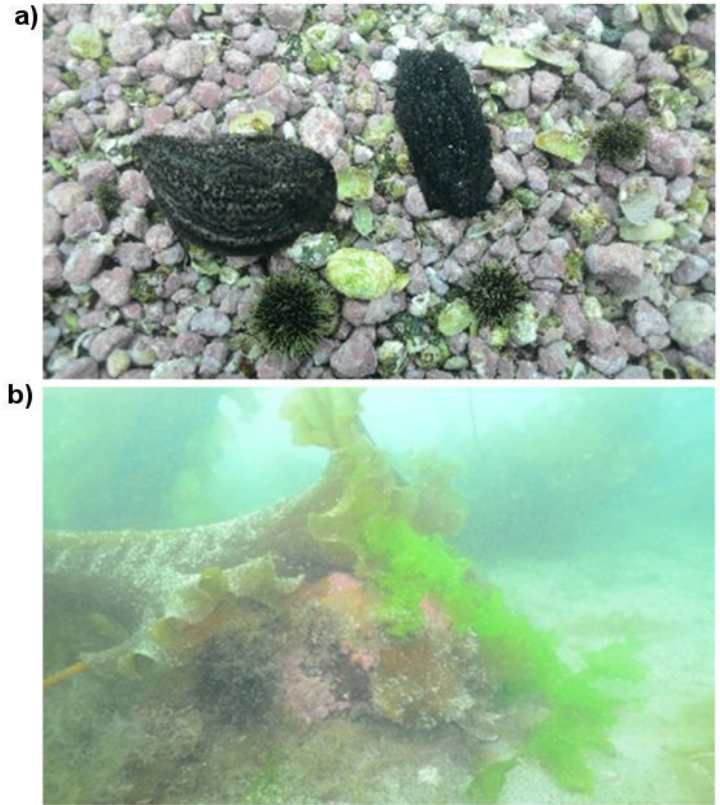
Figure 2. ( a ) Rhodolith beds are dominated by the free-living coralline algae and include shells, stones, and some bedrock covered in CCA, while ( b ) kelp forests are found on bedrock, boulders, shell, or stones often with greater levels of sediment cover.